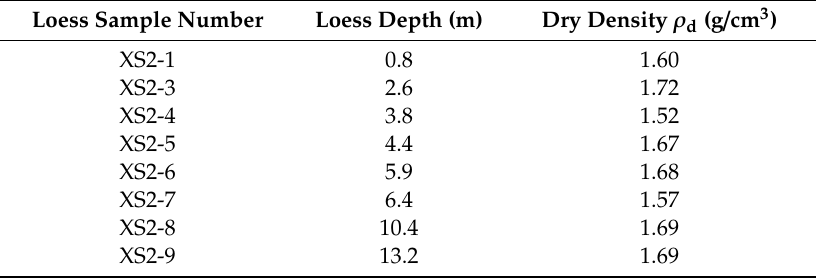
Table 1. Density test